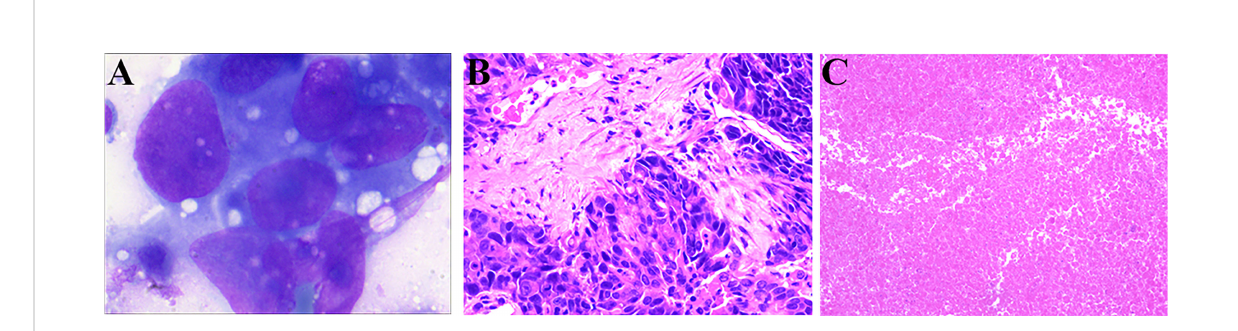
FIGURE 3 Enhanced computed tomography (CT) scans show that the cancer lesion changed over time. (A) CT results (2020.12.2) at the time of diagnosis. (B) CT results (2020.2.9) before the fourth cycle of treatment . (C) CT results (2020.4.23) before the radical